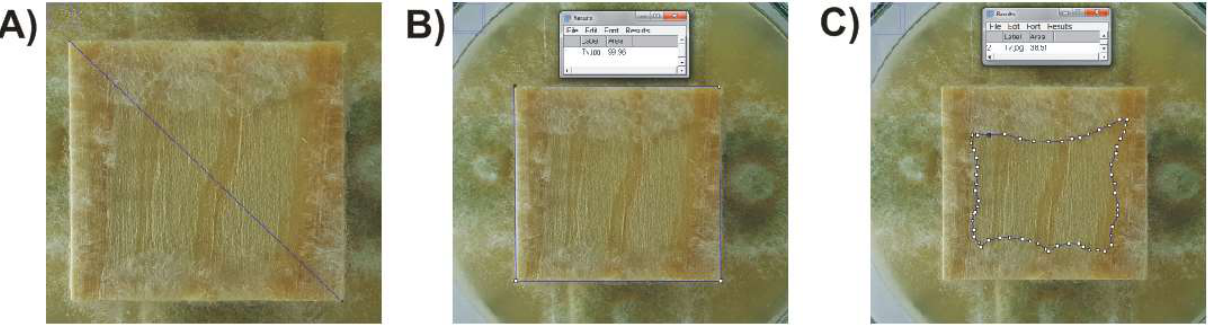
Figure 2. Method (procedure) for determining the area of mycelium overgrowth on the top surface of a wood sample in ImageJ software.